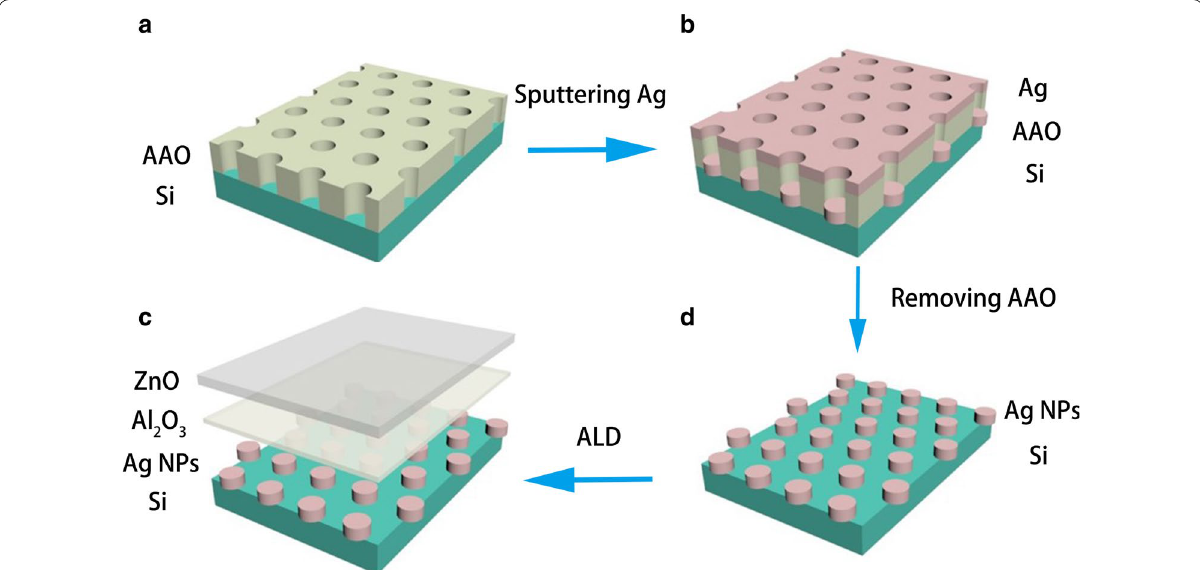
Fig. 1 Fabrication process: a transferred AAO template on Si substrate, b magnetron sputtered Ag on AAO template, c remained silver arrays on Si substrate, d ZnO and Al 2 O 3 on Ag NP arrays deposited by atomic layer deposition